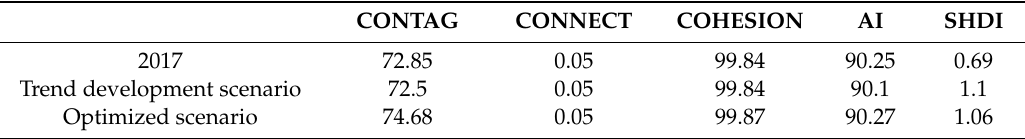
Table 7. Landscape index at landscape level in Puge County from 2017 to 2030